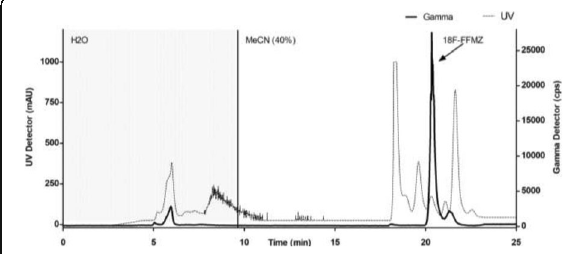
Fig. 1 (abstract PP18). Full HPLC chromatogram of the purification of [ 18